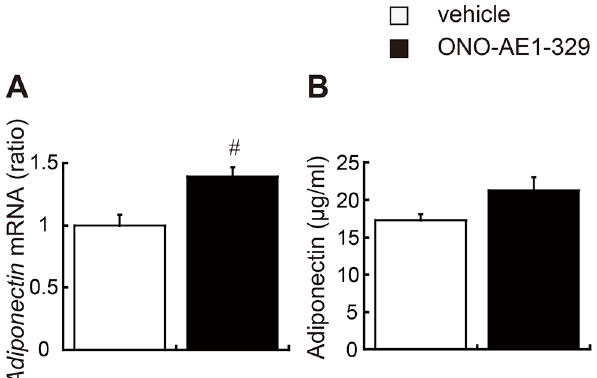
Fig 5. Impact of EP4 activation on adiponectin expression. Relative adiponectin mRNA levels in epididymal fat tissue (A) and plasma adiponectin concentrations (B) were measured in EP4 agonist – (black bar) or vehicle – treated (white bar) db/db mice. All values are mean ± SEM (n = 6 each). ] p < 0.01 vs. vehicle.